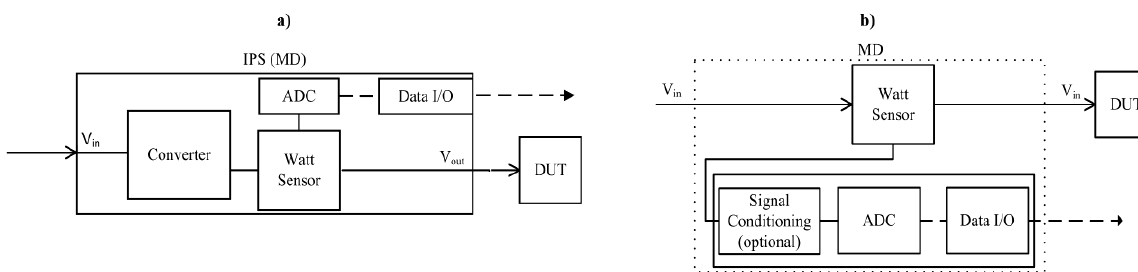
Figure 2. Measurement System Diagram ( a ) IPS based ( b ) Ad-hoc